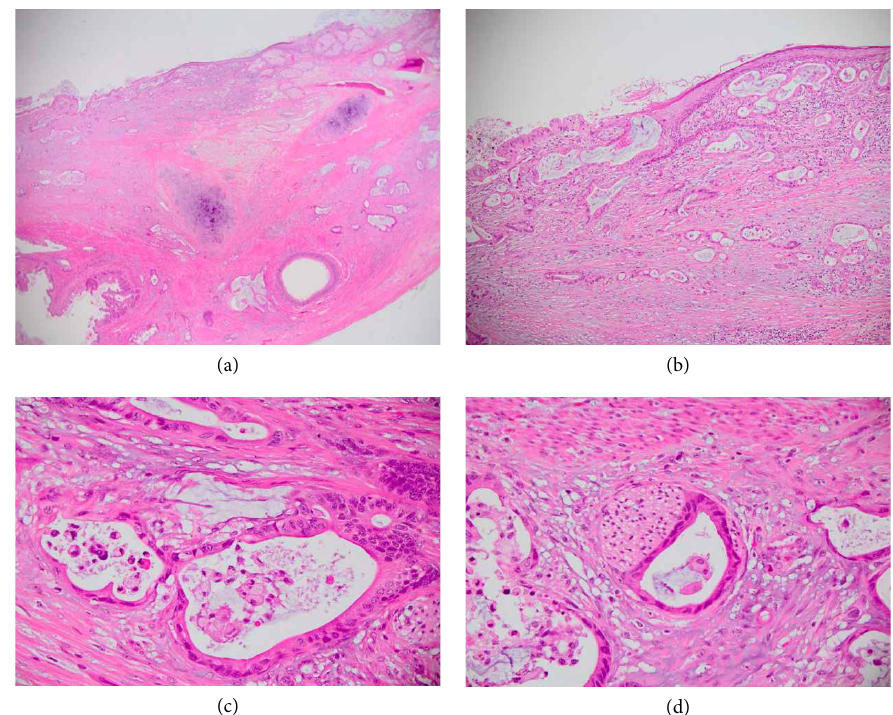
Figure 2: (a) Low power view of teratoma showing skin, glandular epithelium, and cartilage. There is infiltration of malignant glands within the cyst wall (H&E ×40). (b) Transition of benign squamous epithelium to dysplastic surface glandular epithelium and underlying invasive atypical glands with intraluminal dirty necrosis. (c) Invasive glands lined by intestinal-type epithelium and containing intraluminal necrosis. (d) Perineural invasion of infiltrating